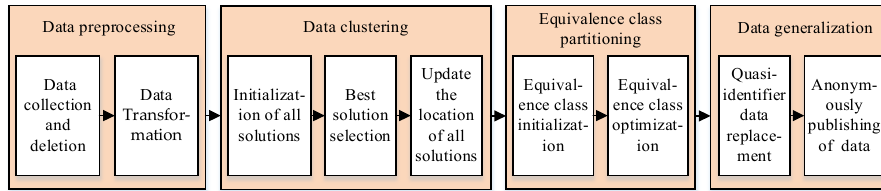
Figure 1. S chematic diagram of